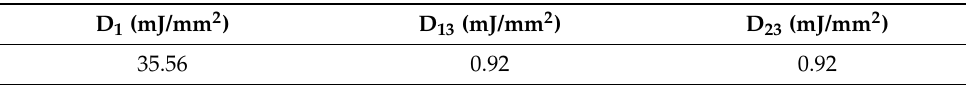
Table 5. The damage evolution parameters of cohesive